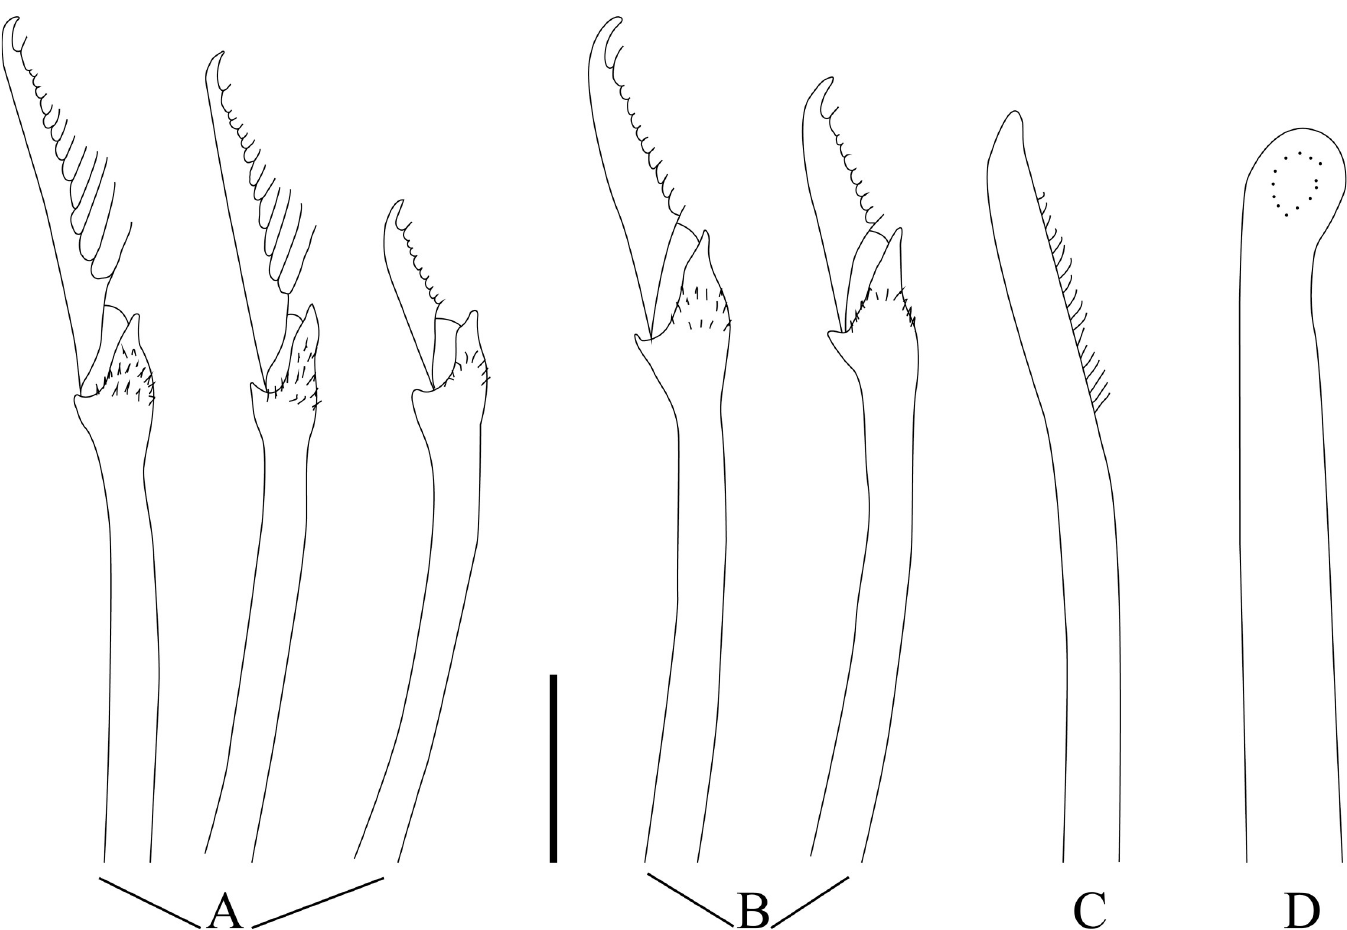
Fig 10. Salvatoria neapolitana . (A). Falcigers, anterior body and midbody; (B). Falcigers, posterior body; (C). Dorsal simple chaeta; (D). Acicula. Scale bar: 10 μ m.